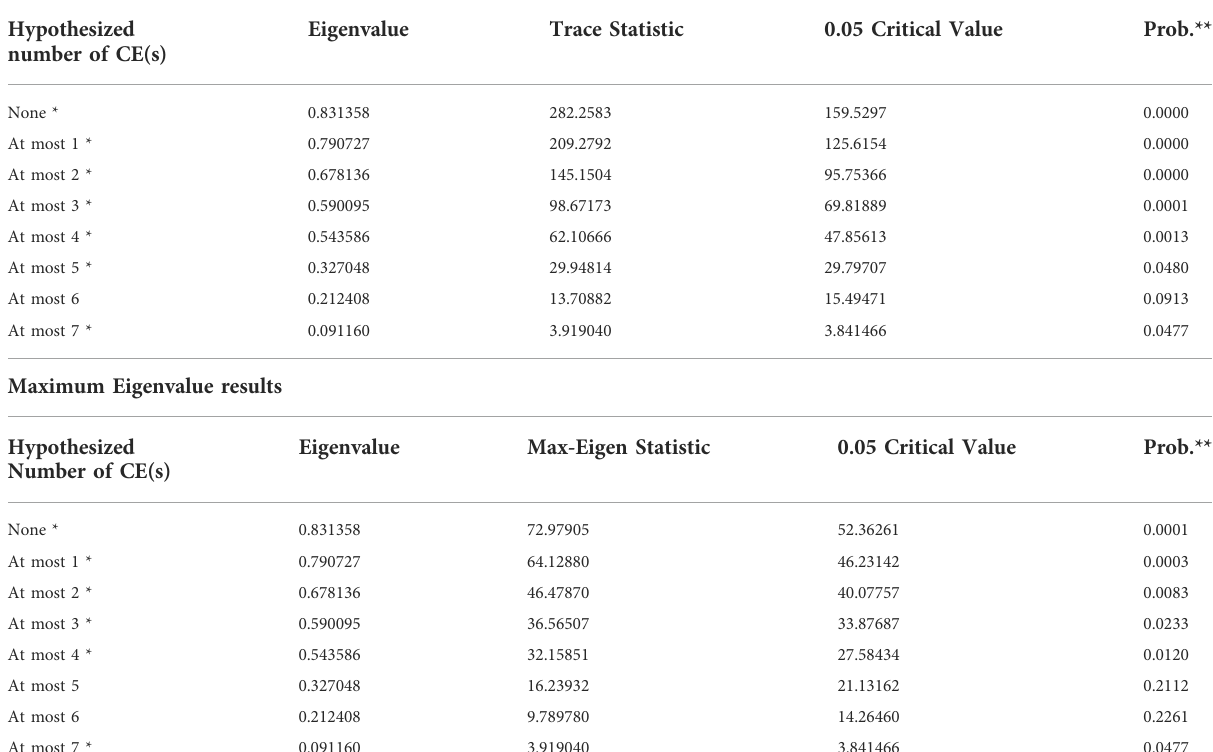
TABLE 8 Johansen method of unrestricted co-integration